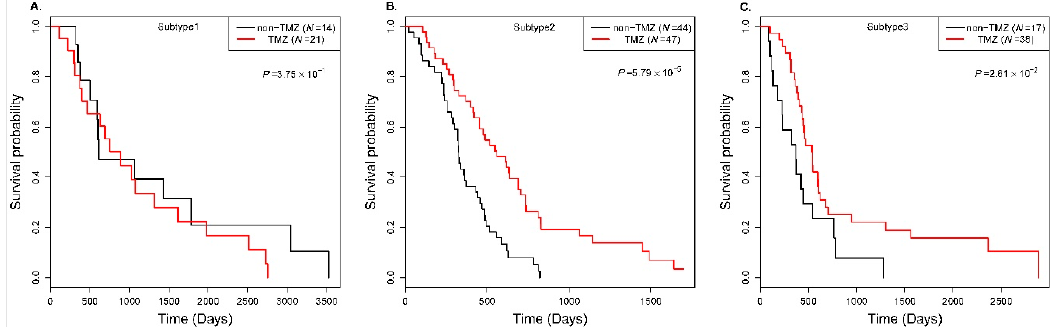
Figure 5. Kaplan–Meier survival possibility curves of patients for temozolomide treatment in the identified subtype clusters in GBM cancer datasets. The Cox log-rank test p -value was included.